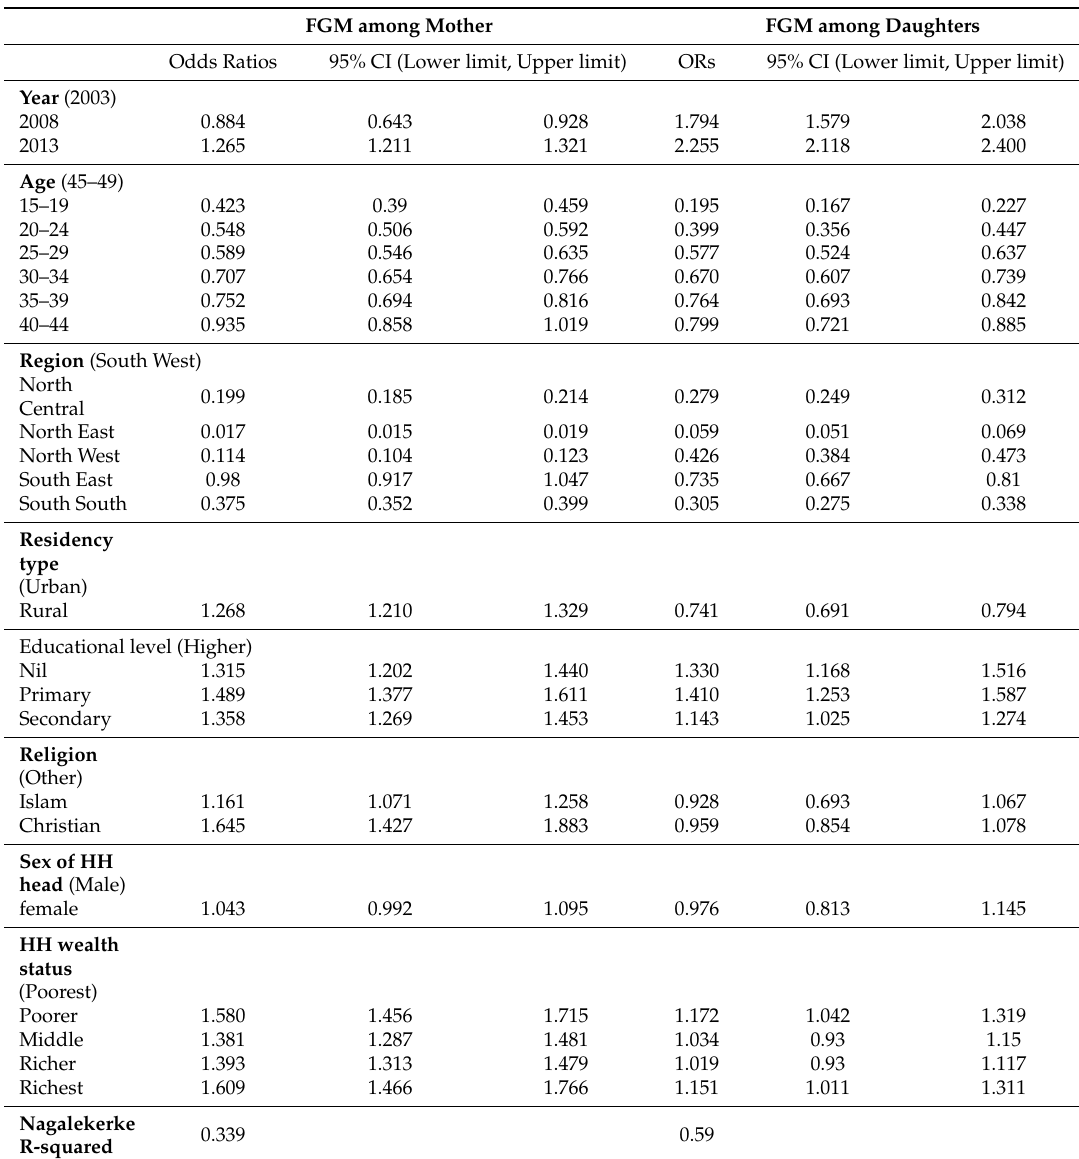
Table 2. Sociodemographic determinants of FGM in Nigeria, NDHS